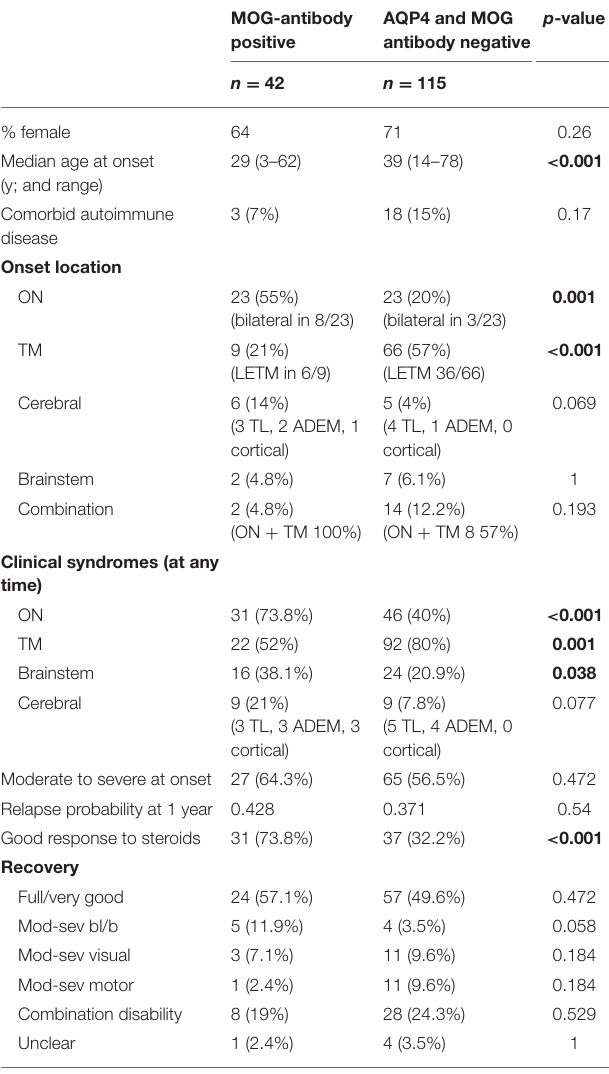
TABLE 2 | Comparison of MOG-antibody positive and AQP4, MOG-antibody seronegative cohorts.